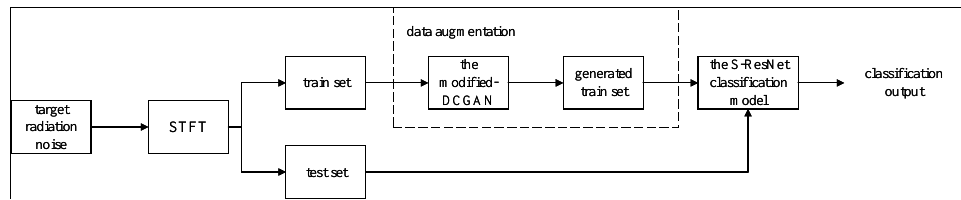
Figure 2. Block diagram of proposed underwater target classification